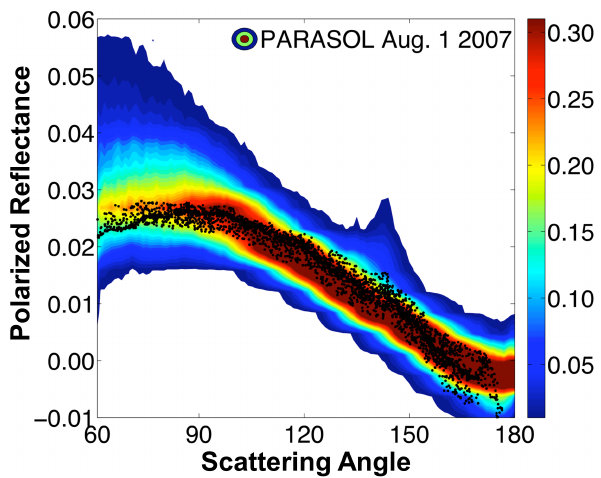
Fig. 11. Polarized reflectivities simulated for the “best” combination of the retrieved habits and roughnesses calculated for data recorded on 1 August 2007. The polarized reflectivities were calculated for the habit and roughness value inferred for each of the 16 available PARASOL pixel directions. The effective diameter is 60µm. Color contours are density of PARASOL polarized reflectivity observa- tions, and black dots are simulations. Each dot represents a calcu- lation of the resulting polarized reflectivity for a single viewing ge-